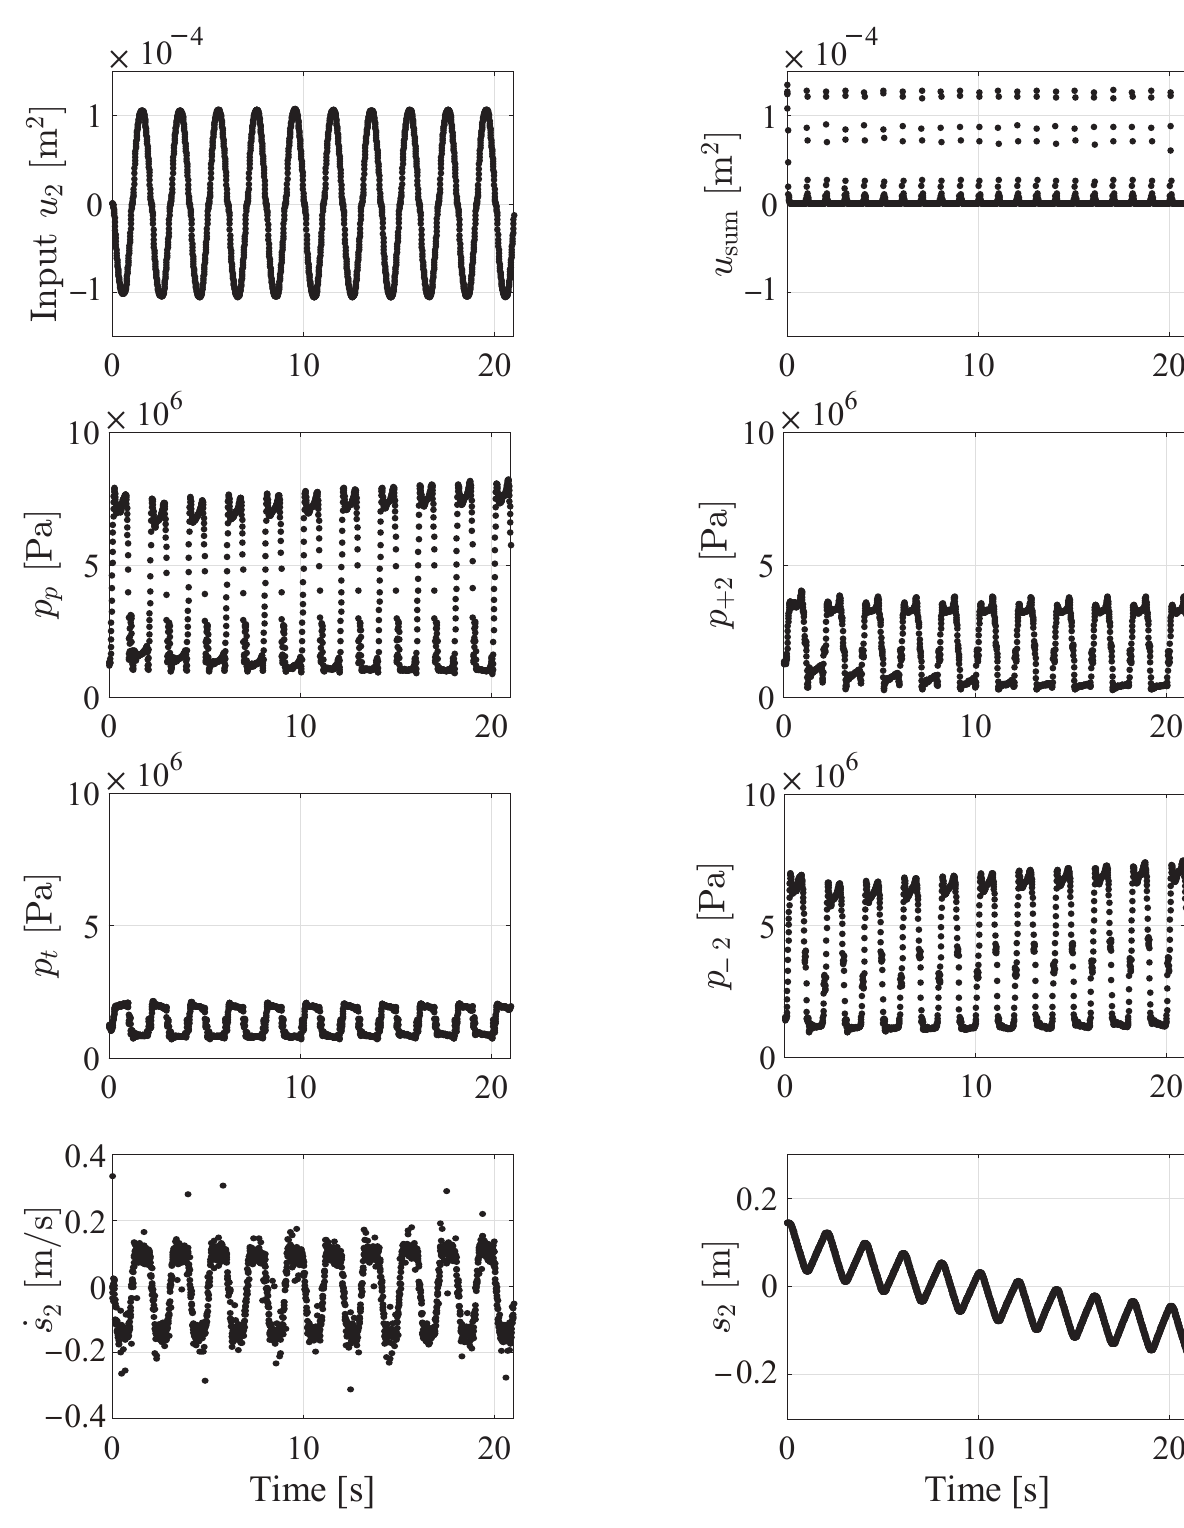
Figure 7. Input u 2 and the outputs (identification, f = 0.5 [Hz], joint